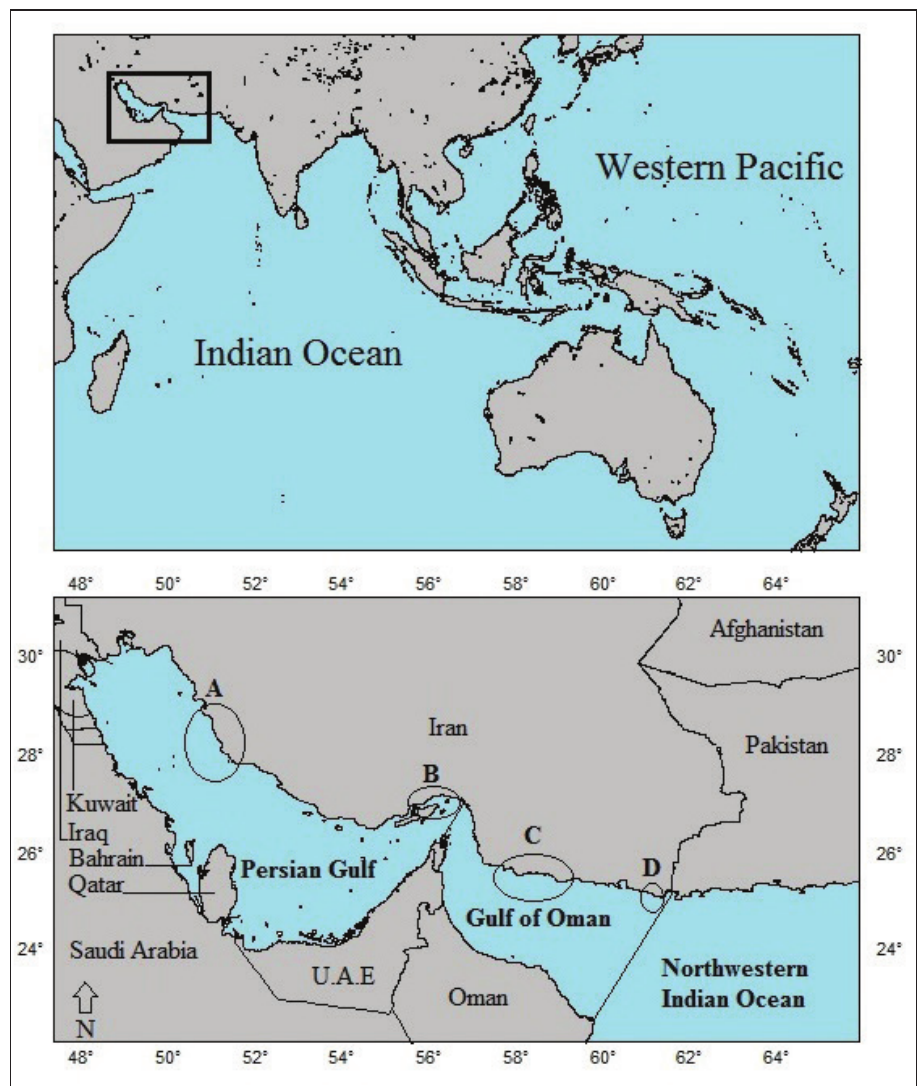
Figure 1. The upper map shows location of the Persian Gulf and Gulf of Oman in the Indo-West Pacific; the lower map shows study sites in the gulfs, including: A Bushehr Province B Qeshm Islands (Qeshm, Larak, Hormouz and Hengam Islands) C Jask and Ras-Meydani D Beris and Pasa-Bandar.